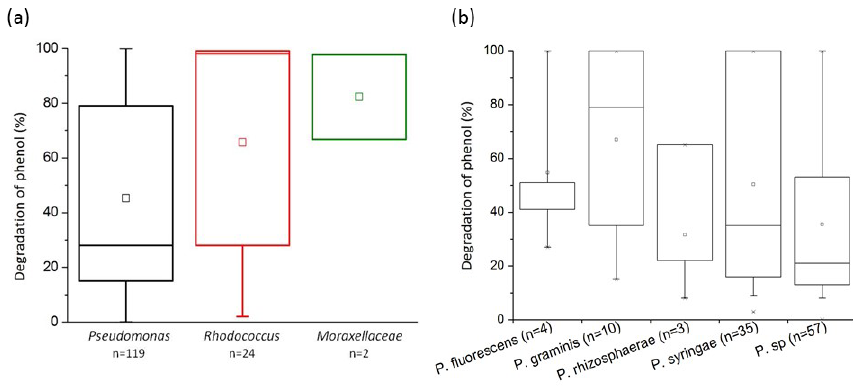
Figure 4. Biodegradation of phenol by bacterial strains isolated from cloud waters. Results are expressed as the percentage of phenol biodegradation measured by HPLC after 5 days of incubation at 17 ◦ C. (a) Results obtained for the 119 Pseudomonas strains, the 24 Rhodococcus strains, and the 2 strains from the Moraxellaceae family. (b) Focus on the Pseudomonas species. Only species groups with a minimum of three strains are plotted